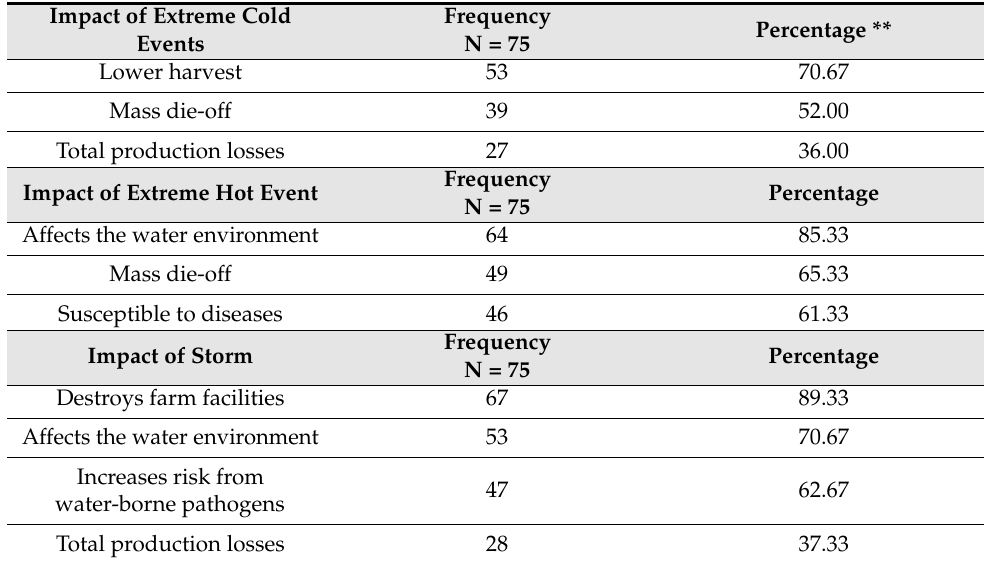
Table 9. Impacts of climate change on aquaculture